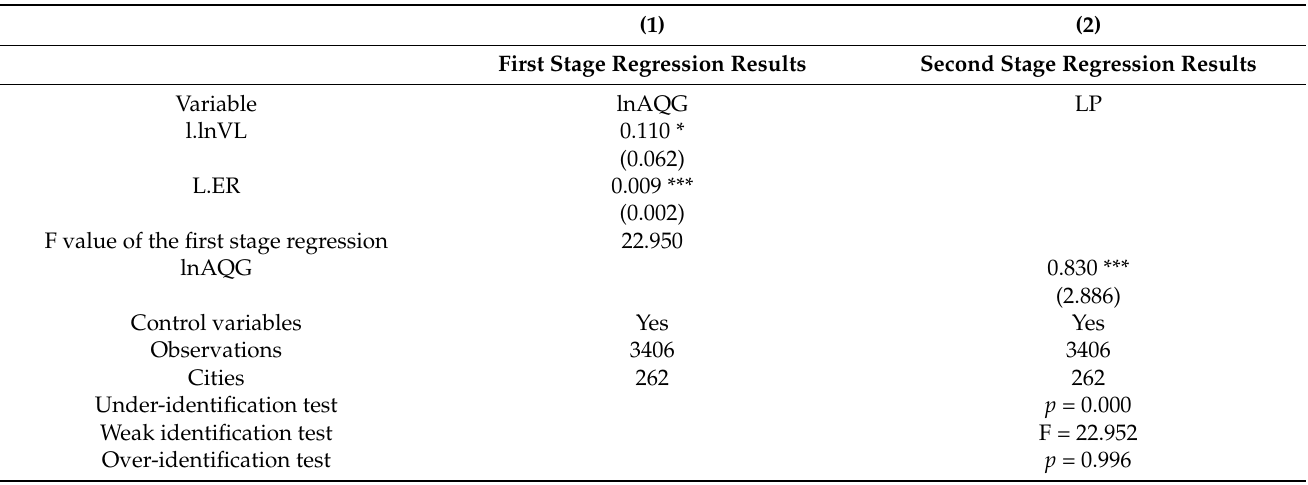
Table 11. Instrumental variable regression